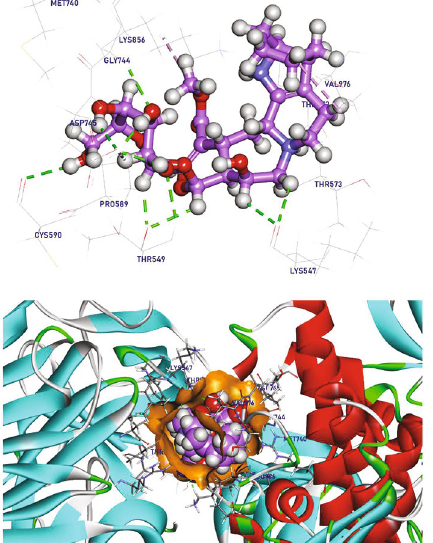
Figure 6: 3-Dihydrocadambine docked in RBD-SARS-CoV-2 Omicron spike protein, hydrogen bonds (green), and the pi interactions are represented in purple lines with mapping surface showing 3-dihydrocadambine occupying the active pocket of RBD-SARS-CoV-2 Omicron spike protein.